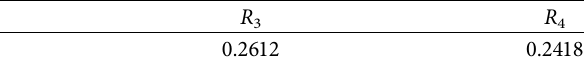
Table 5: The attributes weights r